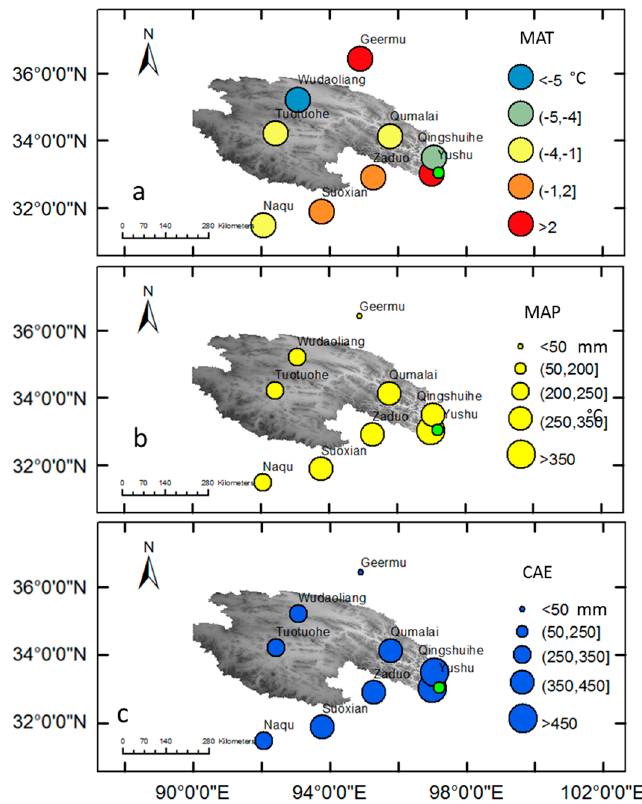
Figure 2. Spatial distribution of annual average hydro-climatic variables in source region of the Yangtze River (SRYR) (1957–2013; ( a ) mean annual temperature in °C; ( b ) mean annual precipitation in mm; and ( c ) calculated mean annual evapotranspiration in mm.